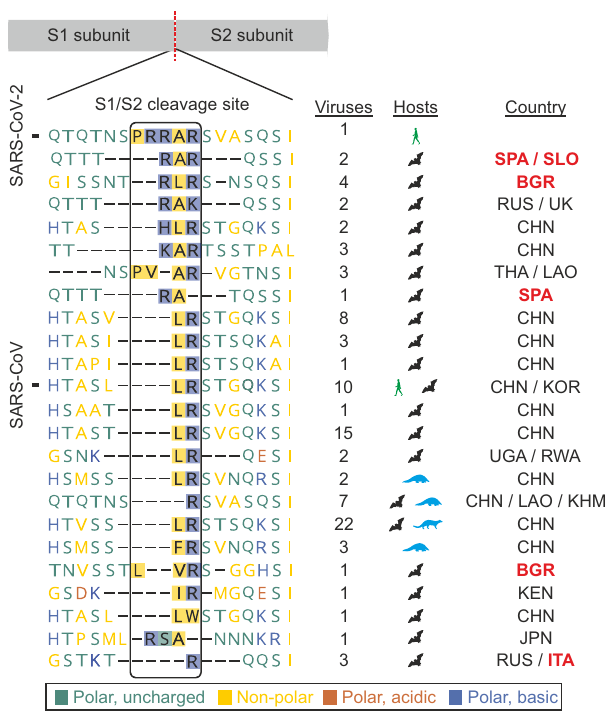
Fig. 2 Comparison of the S1/S2 genomic region in SARS – related coronaviruses. A scheme of the spike protein and its subunits S1 and S2 shows the position of the furin cleavage site (FCS) in SARS-CoV-2. Amino acid residues of the polybasic FCS in SARS-CoV-2 are highlighted within the box. European horseshoe bat SrC sequences generated within this study are indicated by country names in bold red. BGR, Bulgaria; CHN, China; ITA, Italy; JPN, Japan; KEN, Kenya; KHM, Cambodia; KOR, Korea; LAO, Laos; RUS, Russia; RWA, Rwanda; SLO, Slovenia; SPA, Spain; THA, Thailand; UGA, Uganda; UK, United